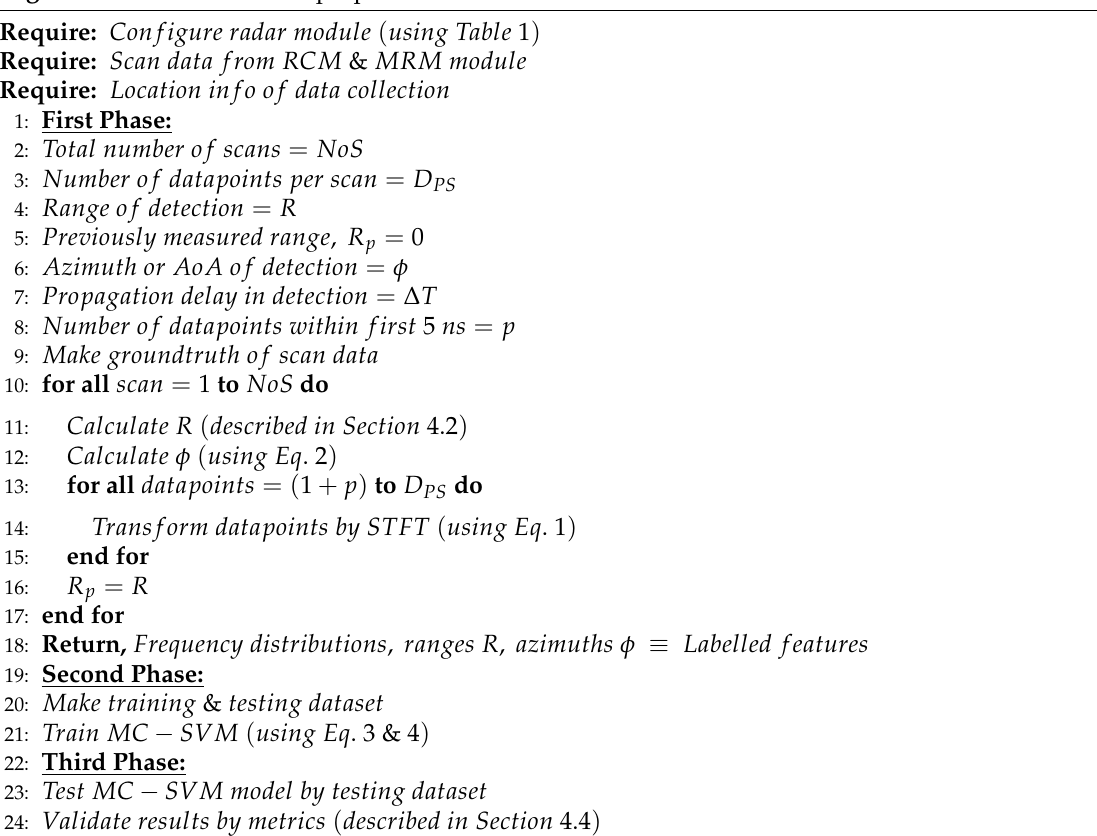
Algorithm 1 Pseudo code of proposed